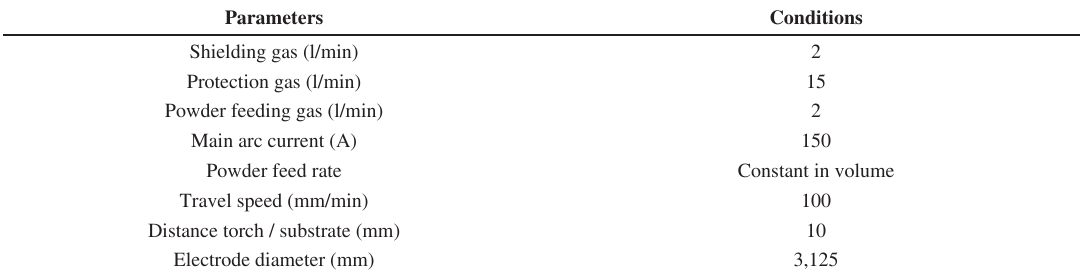
Table 2. Plasma Transferred Arc processing parameters.